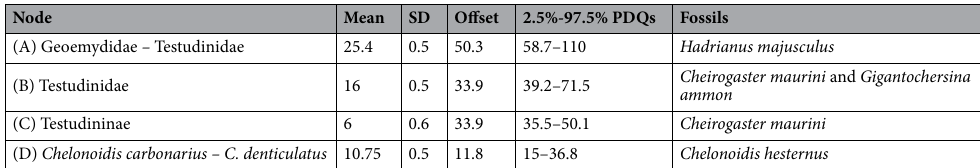
Table 2. Calibration points (following Kehlmaier et al. 34 ) used for the uncorrelated lognormal relaxed clock models implemented in BEAST. Dates were set in million of years ago. For details, see Supplementary Information. PDQs posterior distribution